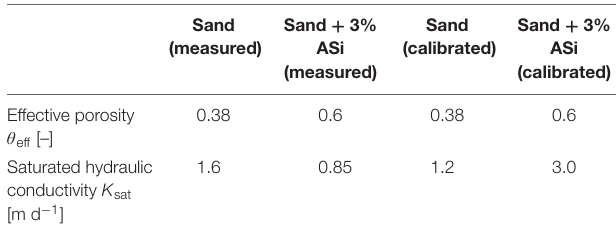
TABLE 1 | Measure and calibrated soil characteristics for the pure sand and sand containing 3%